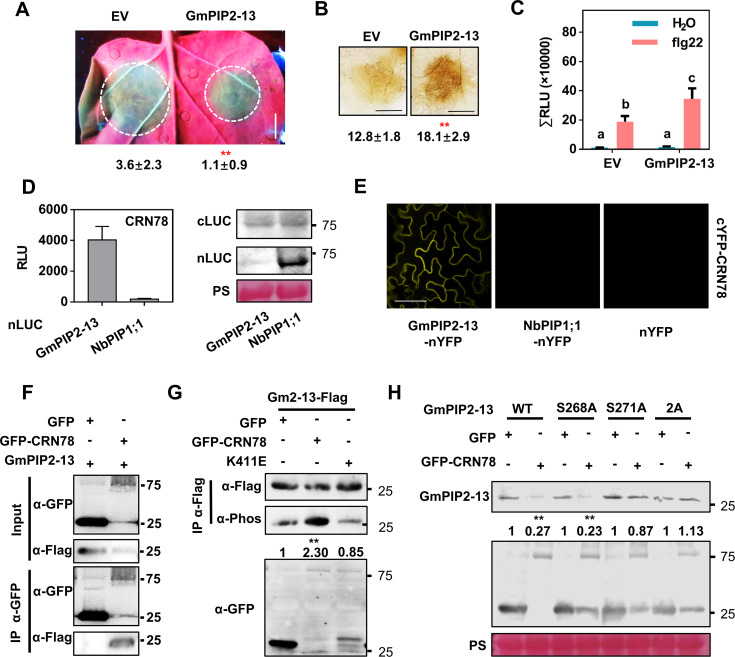
Soybean GmPIP2-13 is subject to CRN78-mediated phosphorylation and subsequent degradation.(A) Reduced P. capsici infection in leaves expressing GmPIP2-13. Photographs were taken at 36 hpi under UV light. Lesion areas were calculated from three independent biological replicates with at least five leaves per replicate (mean ± SD; n > 15; **, P < 0.01, Student’s t-test). (B) Enhanced ROS accumulation in leaves expressing GmPIP2-13. Leaves were collected for DAB staining at 12 hpi. Integral grey value of DAB stained region was shown below (mean ± SD; n = 6, P < 0.01; Student’s t-test). (C) ROS burst elevated by flg22. Total relative luminescence units (RLU) were detected at 30 min after treatment. The results shown are a representative of three independent experiments with eight replicates. Different letters indicate significant differences (mean ± SD; n > 10; P < 0.01, Student’s t-test). (D) CRN78 interacts with GmPIP2-13. Chemiluminescence signals were detected at 48 hours post infiltration. Proper protein expression is shown on the right. (E) Interaction between CRN78 and GmPIP2-13 in a BiFC assay. YFP fluorescence was observed 48 hours after infiltration. Scale bars: 20 μm. (F) Interaction between CRN78 and GmPIP2-13 in a Co-IP assay. Total proteins were extracted from N. benthamiana leaves expressing the indicated proteins. The immune complexes were immunoprecipitated with an α-GFP beads, and the bound protein was detected by immunoblotting. (G) Phosphorylation of GmPIP2-13 by CRN78 in vivo. Numbers below the blots represent the relative abundance of phosphorylated GmPIP2-13. α-Flag immunoblotting was used to show equal loading. (H) Protein accumulation levels of GmPIP2-13 mutants in the presence of CRN78. Protein levels were analyzed by western blotting at 48 hours post infiltration. Ponceau staining was used to show equal loading. Numbers below the blots represent the relative abundance of GmPIP2-13 -Flag.